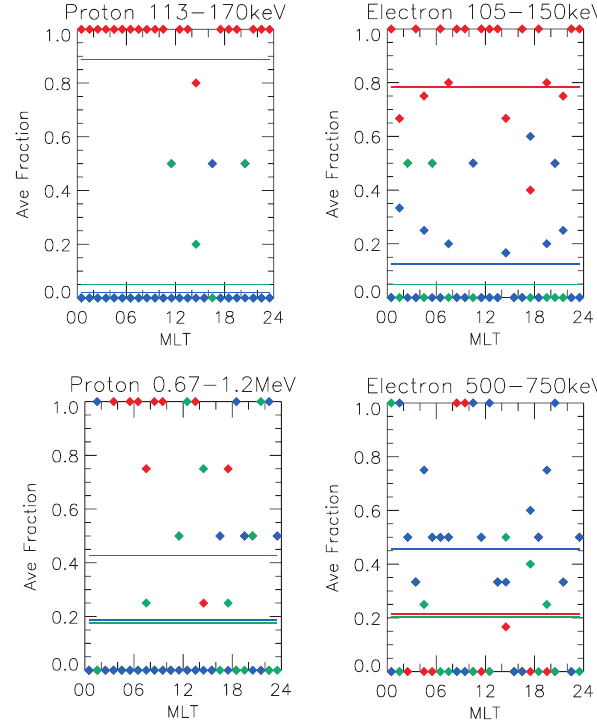
Fig. 4. Local-time distribution of proton and electron flux response to the dynamic pressure enhancements for 2 selected channels each for protons and electrons during non-storm times.